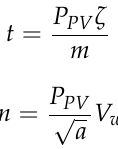
Figure 8. Forecasting the daily electricity demand in 2022. Figure 9. Schematic hybrid system.